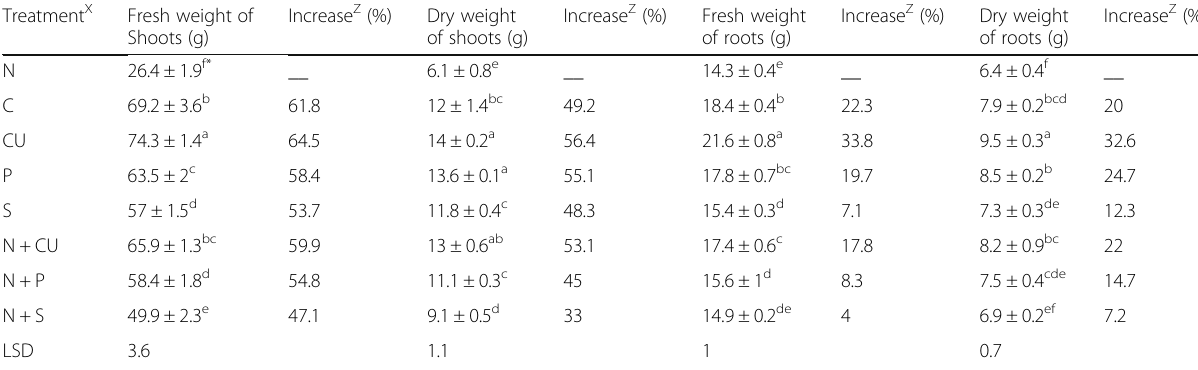
Table 2 Effect of culture broth, cell pellet, and supernatant of Bacillus subtilis isolate B10 on fresh and dry weight of shoots and roots of tomato plants Treatment X Fresh weight of Increase Z (%) Shoots (g)